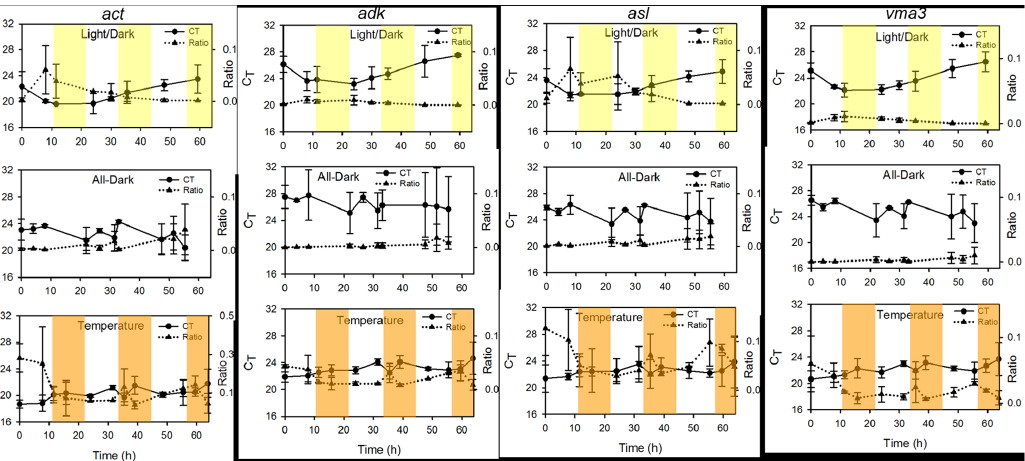
Figure 5. Correlation between gene expression and C T values as derived from absolute quantification of transcript and gene copy numbers. Standard curves were created for the act , adk , asl , and vma3 genes and used to calculate the transcript-to-gene ratios under conditions of light/dark cycling, temperature fluctuation, and continuous darkness. Top panel depicts light/dark cycling, with yellow highlight indicating light on. Bottom panel displays conditions of temperature flux between 25 ˚ C and 37 ˚ C, with 37 ˚ C illustrated by orange